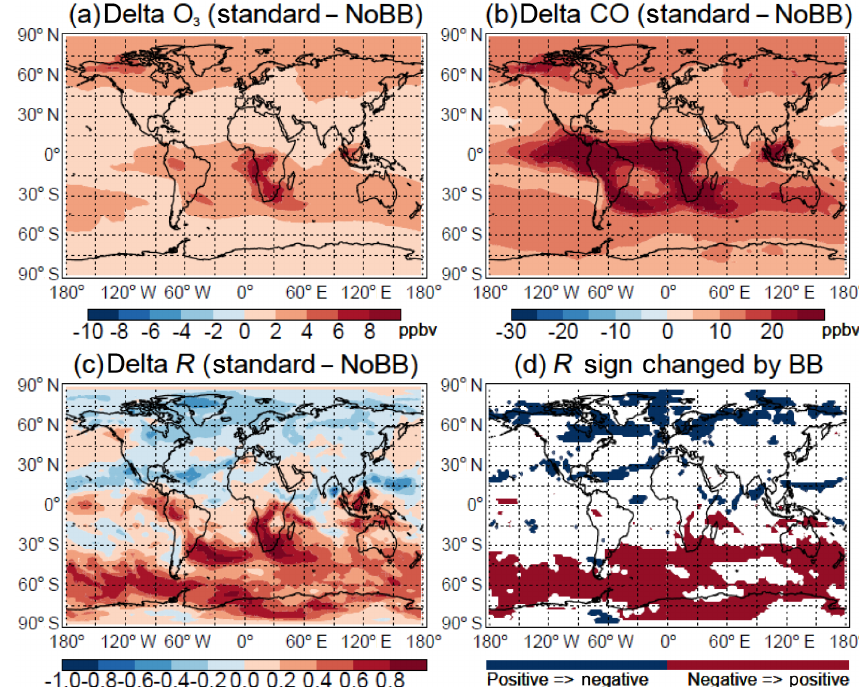
Figure 17. Same as Fig. 16 but for the sensitivity of O 3 , CO, and their correlations at 618hPa to biomass burning (BB) emissions.